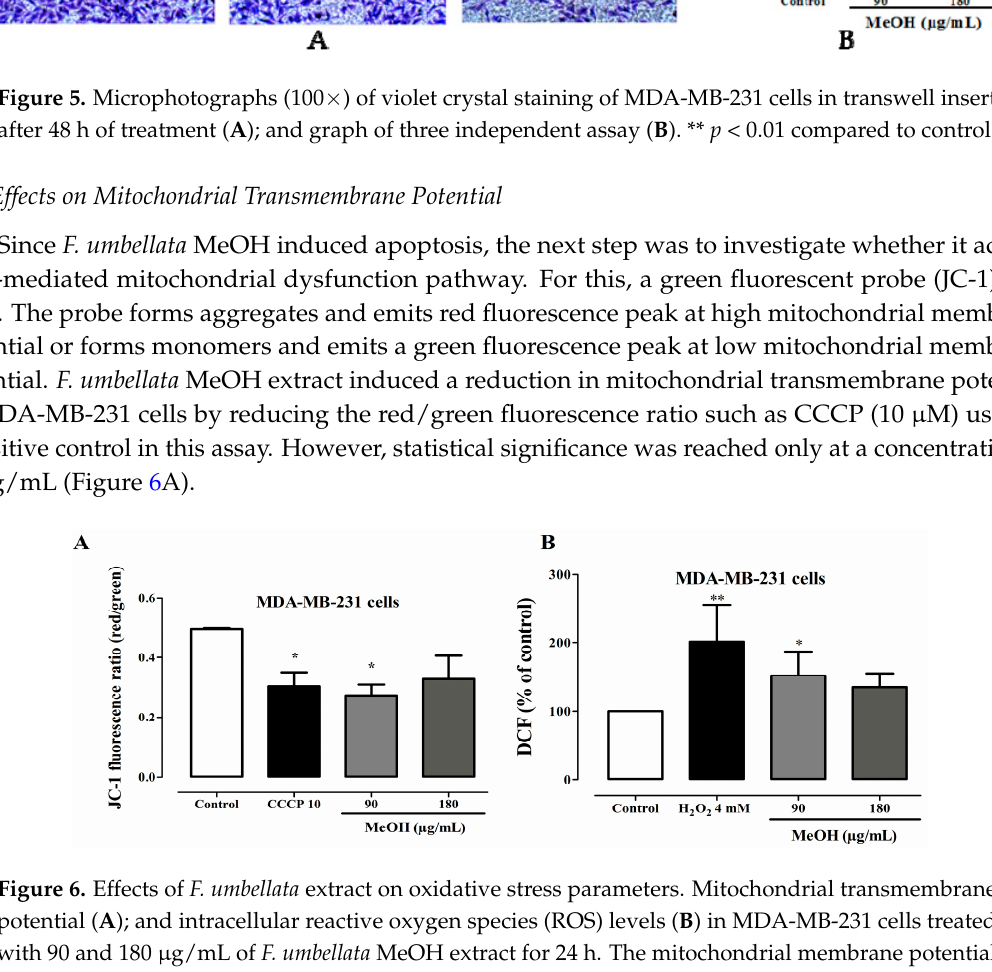
Figure 5. Microphotographs (100×) of violet crystal staining of MDA-MB-231 cells in transwell insert after 48 h of treatment ( A ); and graph of three independent assay ( B ). ** p < 0.01 compared to control.